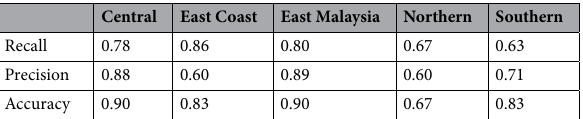
Table 11. Testing Data Set Results with Optimal Parameter: Kernel = rbf,